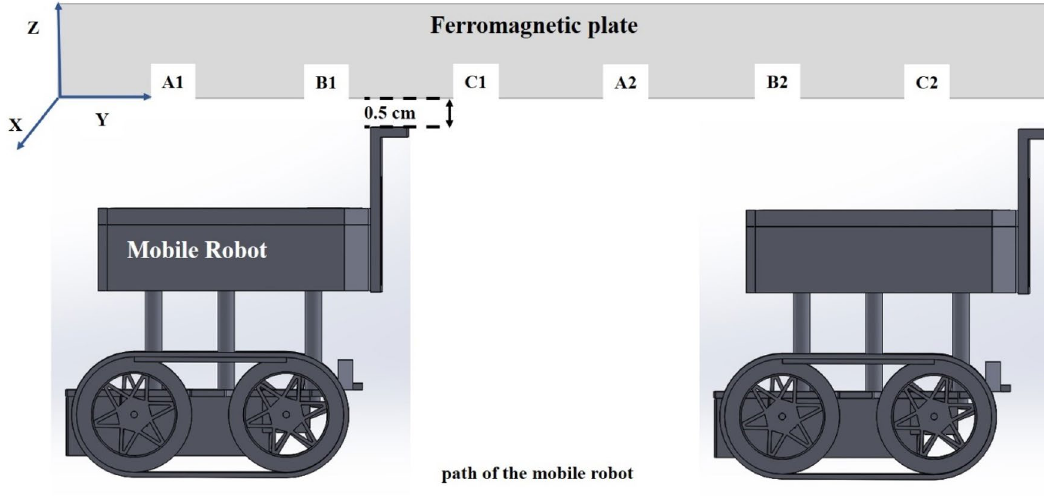
Fig. 4 Proposed arrangement for the path of the mobile robot along a ferromagnetic